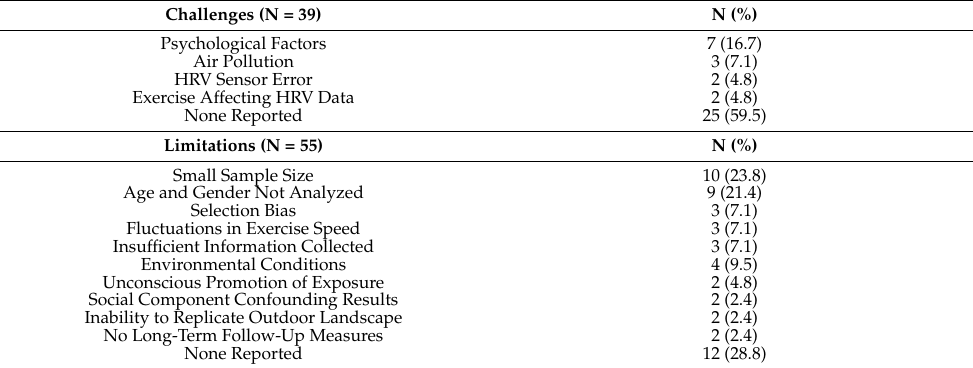
Table 6. Challenges and Limitations of HRV Studies in Outdoor